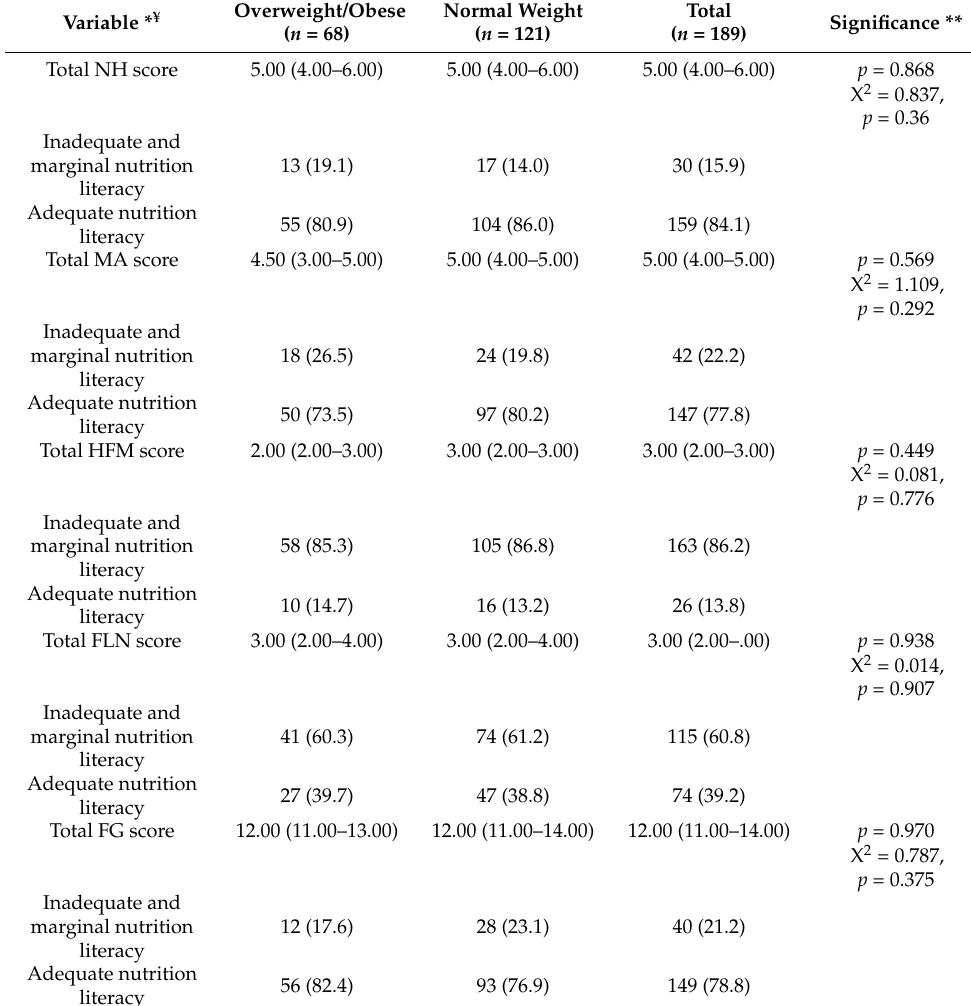
Table 2. Median (IQR) of nutrition literacy scores and the distribution of adequate nutrition literacy by BMI category ( n = 189) }